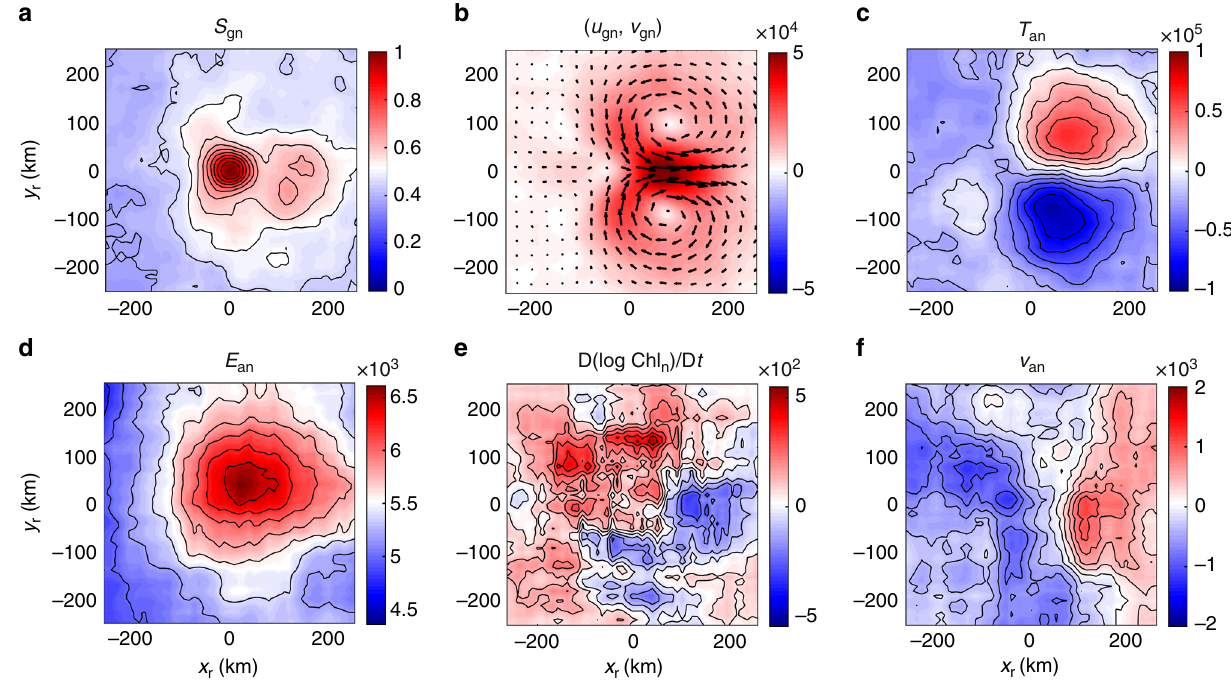
Fig. 5 Southern Hemisphere frontal processes and strong geostrophic strain. Composited distributions of normalized properties in the along-front coordinate: a normalized geostrophic strain rate S gn , b normalized geostrophic velocity fi eld ( u gn , v gn ), where the color represent the speed of the geostrophic fl ow, and the vectors represent the geostrophic velocity fi eld, c normalized surface temperature anomaly T an , d normalized ageostrophic kinetic energy E an , e normalized Lagrangian chlorophyll variation rate D(log Chl n )/D t , and f normalized cross-front ageostrophic velocity v an . All properties are normalized by the strain rate at the centered strain saddle point S gc . Thus, S gn and D(log Chl n )/D t are dimensionless, and the units of ( u gn , v gn ), T an , E an , and v an are m 1 , °C s 1 , m 2 s − 1 , and m 1 , respectively. The along-front and cross-front directions are x r and y r , respectively. All parameters are composited using a moving window with a bin size 25 km × 25 km. Source data are provided as a Source Data fi